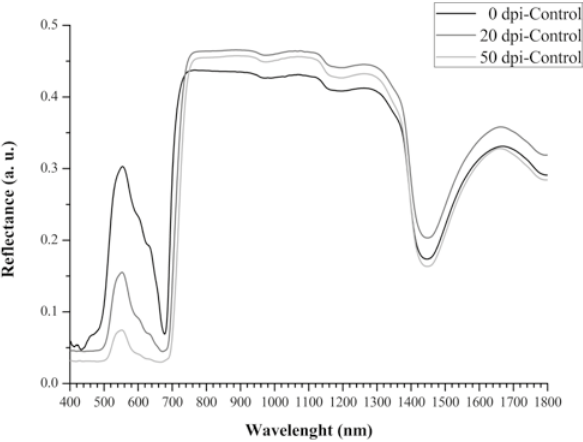
Figure 1. Typical HR spectra for pear leaf samples from 0 dpi-control, 20 dpi-control and 50 dpi-control pear leaves